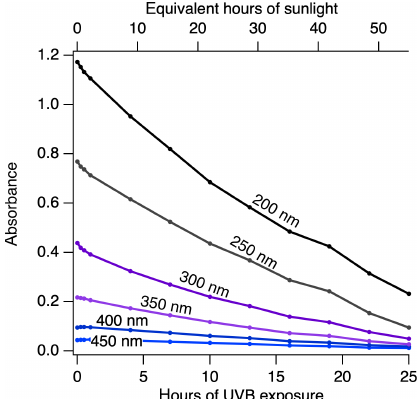
Figure 6. DOM absorbance decreases as a function of irradiation. Absorbance of a 14mgCL − 1 of Great Dismal Swamp 2014 (DS 2014) as a function of UVB exposure leads to photobleaching of the